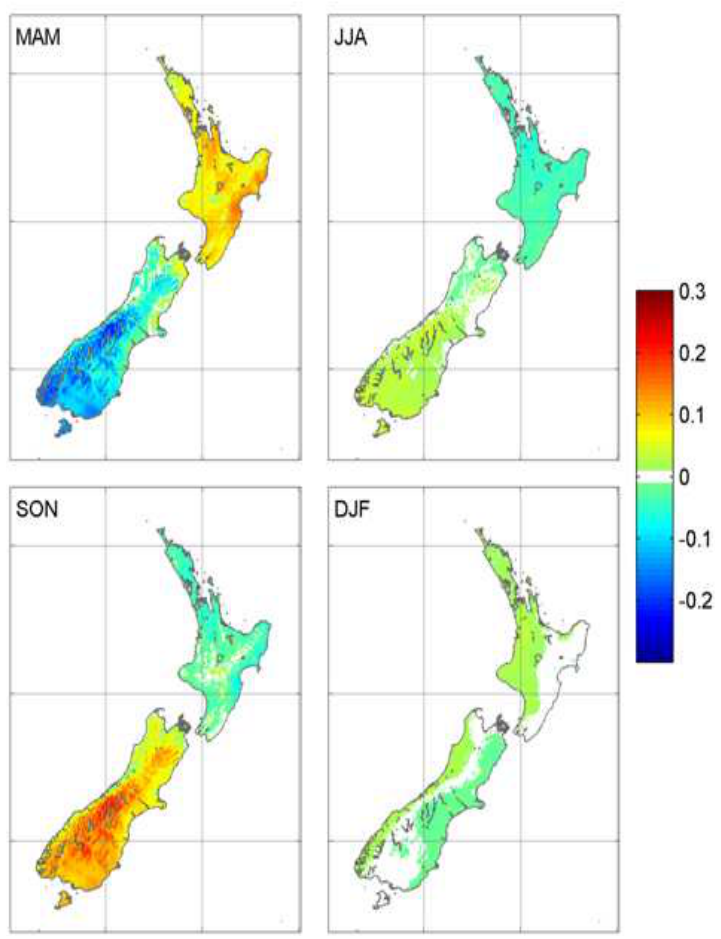
Fig. 7. The ensemble mean change in surface air temperature ( ◦ C) associated with the changes in the frequencies of occurrence given in Table 2 for the MH relative to the PI during MAM, JJA, SON and